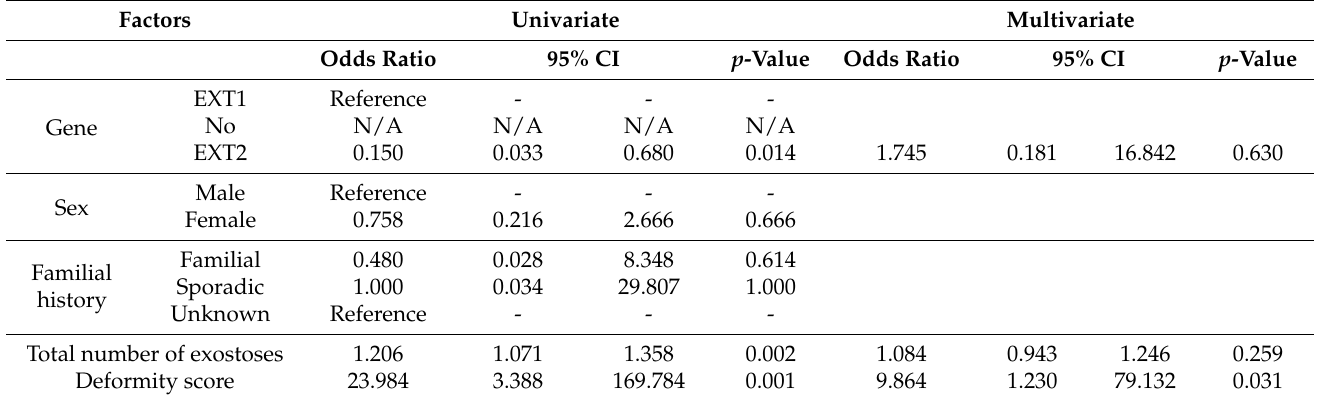
Table 6. Factors associated with the clinical class of ‘severe’ using multivariate regression model.